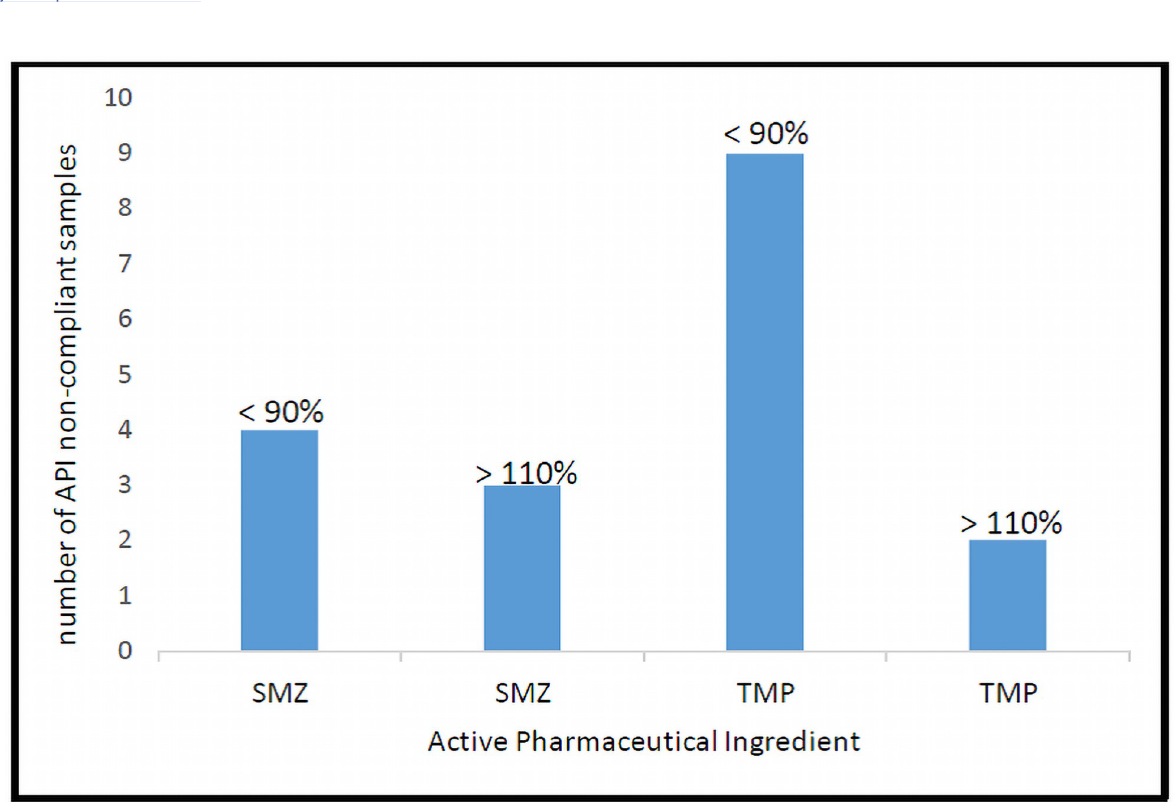
Fig 1. Distribution of API non-compliant samples in both lower and upper limits.